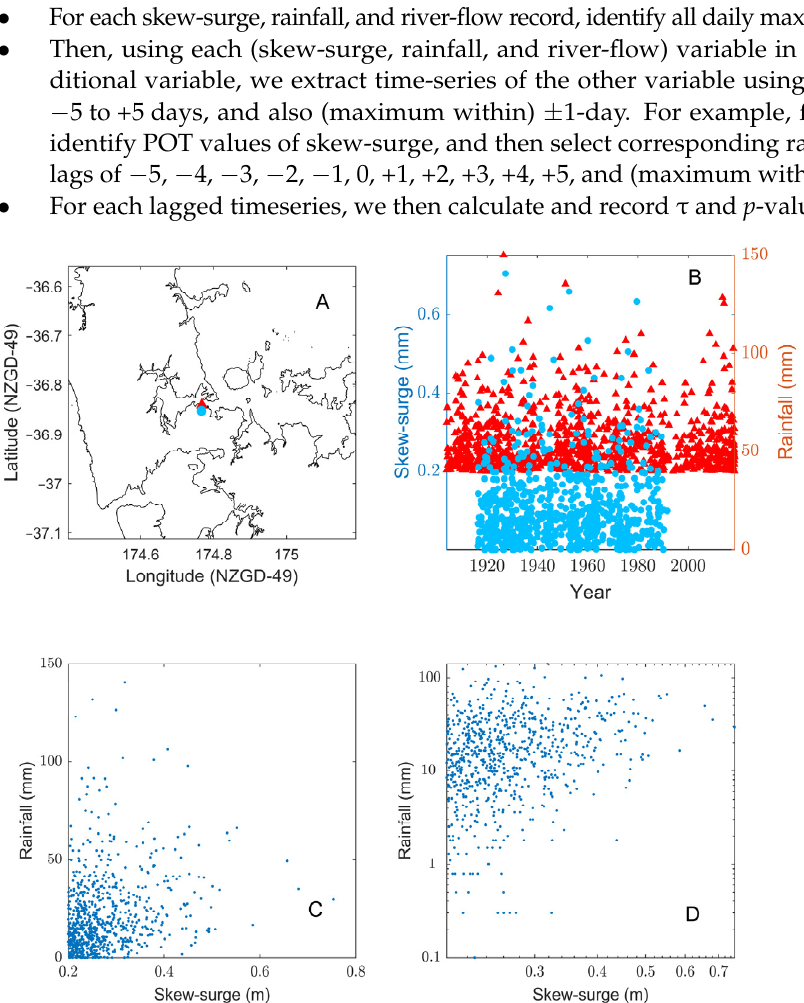
Figure 2. Example of a single timeseries of skew-surge and rainfall for which Kendall’s τ was calculated for the SS/R | SS case ( τ = 0.19 and p -value < 0.05). This example shows maximum daily- accumulated rainfall within ± 1-day (lag). ( A ) Location of sea-level record (site 5, Auckland, Figure 1), plotted in the red triangle, and rainfall record, plotted in the blue circle. ( B ) Timeseries of skew-surge peaks-over-threshold (red triangles) and matching maximum daily-accumulated rainfall within ± 1-day (blue circles). The rainfall record does not span the full duration of the sea-level record. ( C ) Scatter plot of the matched skew-surge and rainfall (for the period of overlap). ( D ) Scatter plot of the matched skew-surge and rainfall using log-log